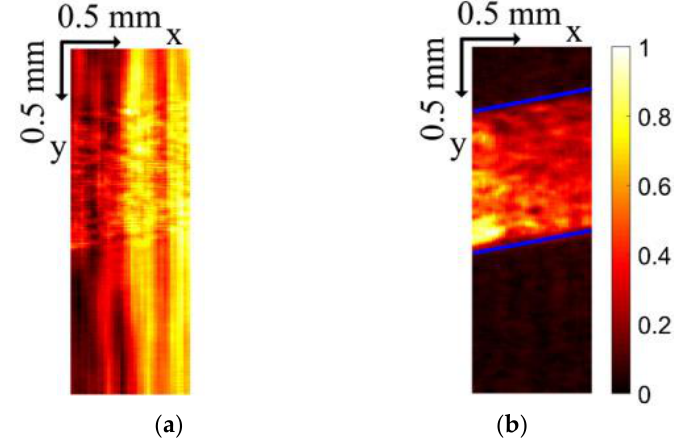
Figure 27. Results of experimental imaging: ( a ) laser confocal feedback imaging, ( b ) ultrasound modulated laser confocal feedback imaging. (Figure reproduced from Ref. [97]).